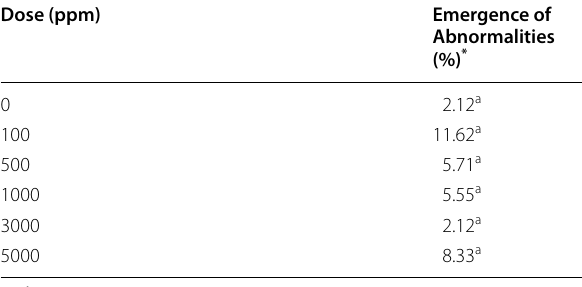
Table 7 Effect of zinc oxide NP on the emergence of morphological abnormalities in the adults of G.